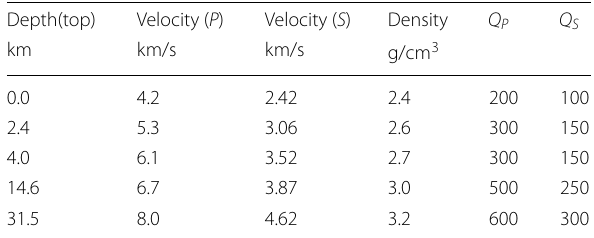
Table 1 Velocity structure model used to calculate the synthetic